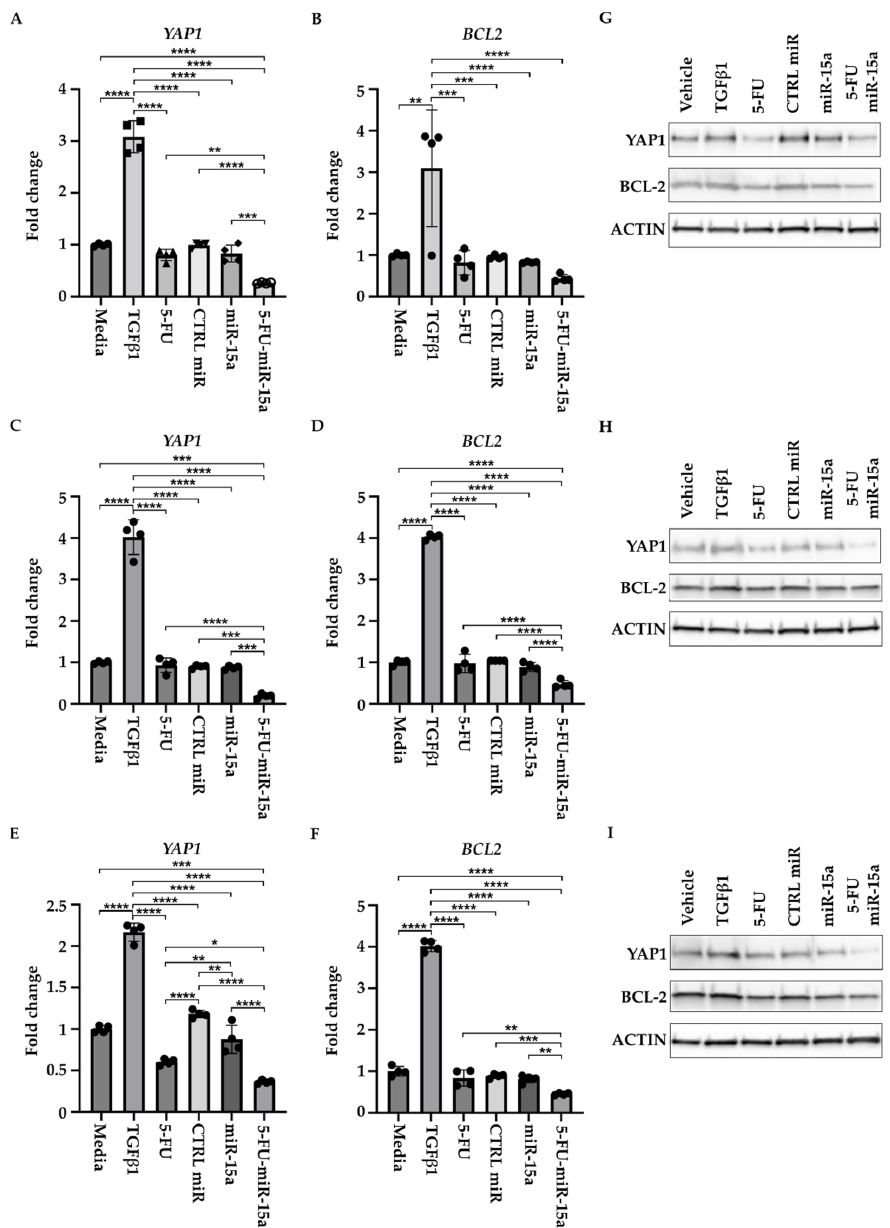
Figure 11 . 5-FU-miR-15a inhibits YAP1 and BCL-2 levels of human pancreatic stellate cells in vitro. Human pancreatic stellate cells were treated with TGF β 1 or 5-FU, CTRL miR, miR-15a, and 5-FU-miR-15a, and samples for RNA and protein analysis were collected 24 h post-treatment. RNA analysis of YAP1 and BCL2 levels. ( A , B ) hPSCs obtained from Creative Bioarray; ( C , D ) hPSCs obtained from CelProgen; ( E , F ) hPSCs obtained from ScienCell. Data are represented as the mean ± SD; N = 12 for a single treatment and N = 6 for a double treatment. * p < 0.05, ** p < 0.01, *** p < 0.001, and **** p < 0.0001 by one-way ANOVA. Western analysis of YAP1 and BCL2 levels ( G ) hPSCs obtained from Creative Bioarray; ( H ) hPSCs obtained from CelProgen; ( I ) hPSCs obtained from ScienCell.